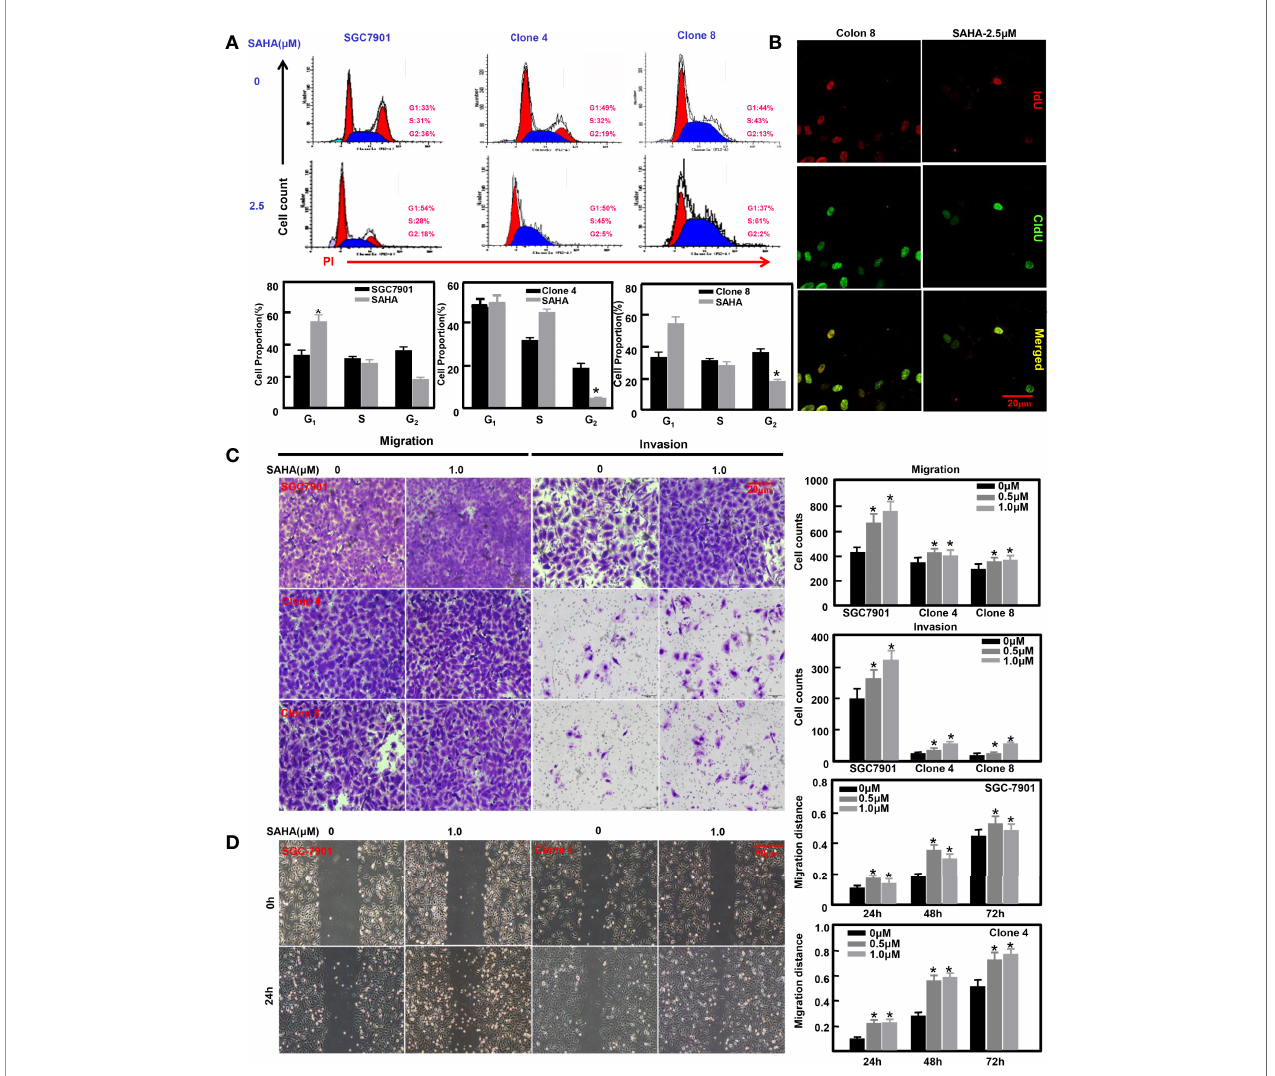
FIGURE 4 | The anti-tumor effects of SAHA on ING5-overexpressing gastric cancer cells SGC-7901 and its ING5 transfectants (Clones 4 and 8) were treated with SAHA at 0.5 and 1.0 m M. After exposure, they were subjected to PI staining and fl ow cytometry (A) . Among them, clone 8 was stained using IdU and CIdU to differentiate the early and late phases of DNA synthesis (B) . Transwell (C) and wound healing (D) assays were employed to analyze the effects of SAHA on migration and invasion of these cells. Note: *, compared with 0 m m,